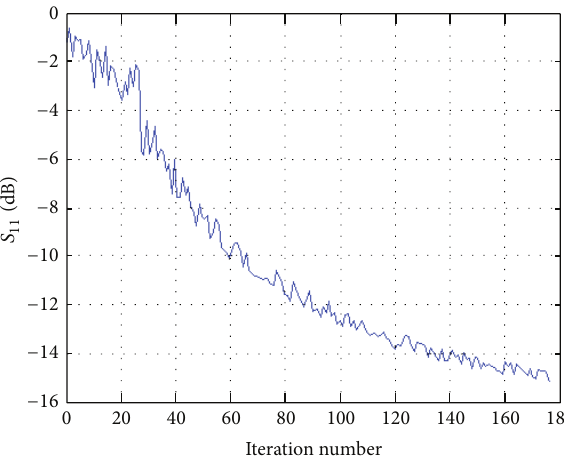
Figure 2: 𝑆 11 of the rat-race coupler versus IWO iteration number.